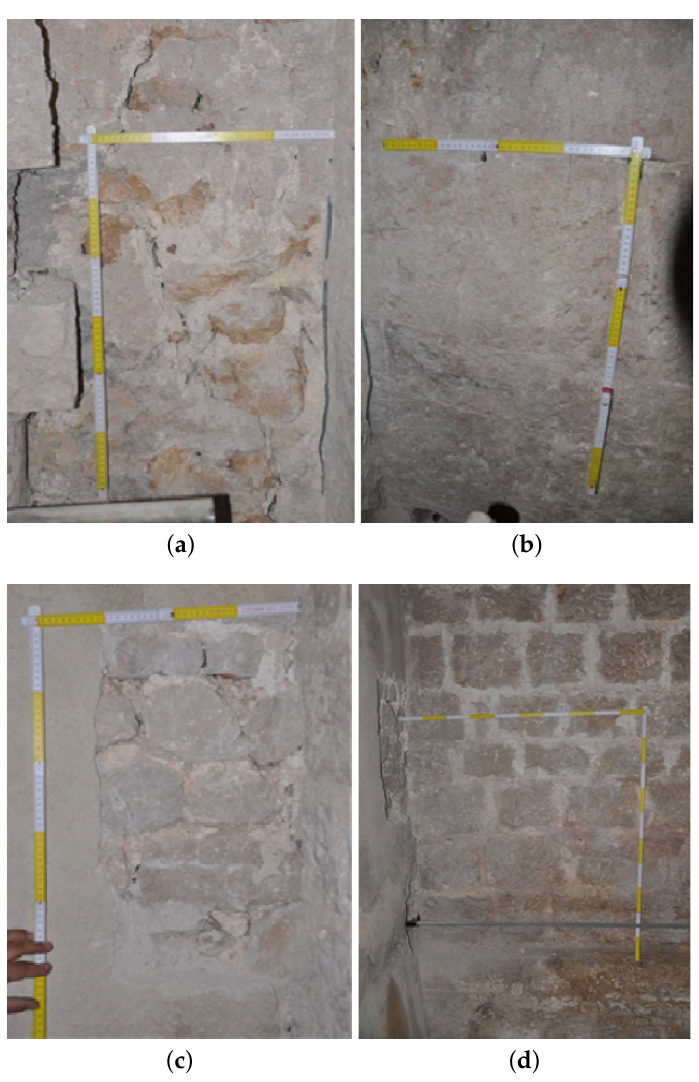
Figure 16. Characterization of the masonry surveys: ( a , b ) views of the first test, CS1; ( c , d ) views of the second test, CS2, taken by Fine Art Authority.